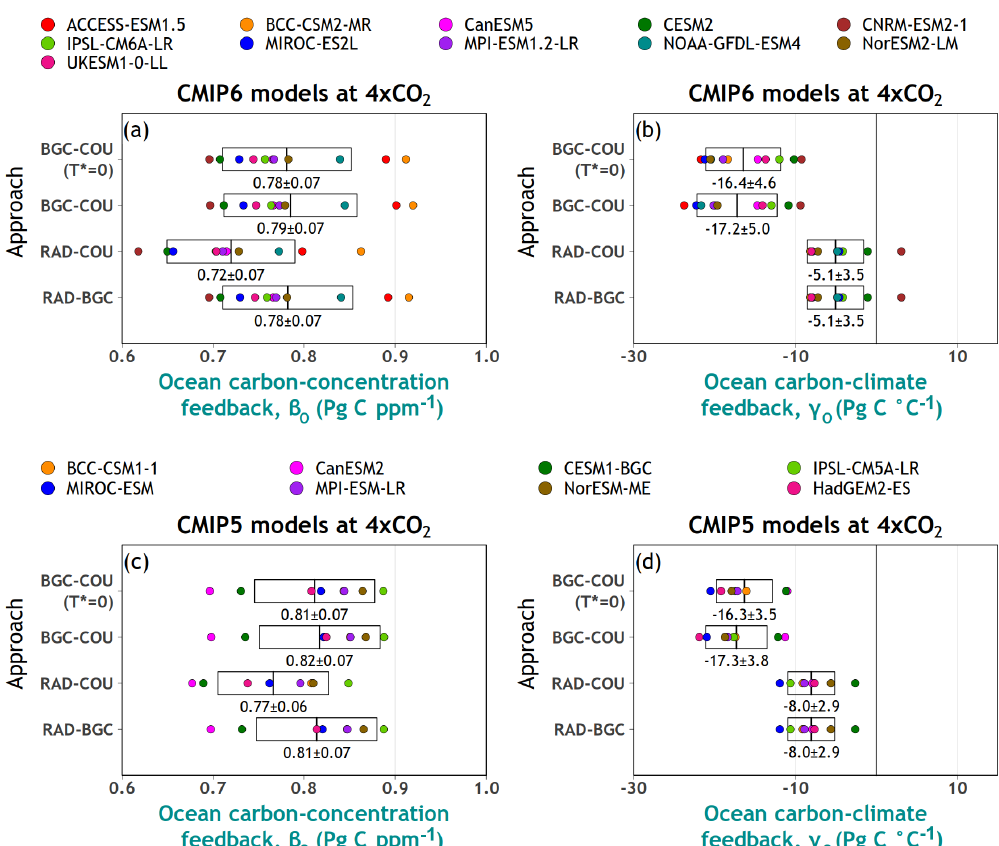
Figure 6. Carbon–concentration (a) and carbon–climate (b) feedback parameters over ocean from participating CMIP6 models calculated using the approaches summarized in Table 1. The boxes show the mean ± 1 standard deviation range. Results from participating CMIP5 models in the A13 study are shown in (c) and (d)